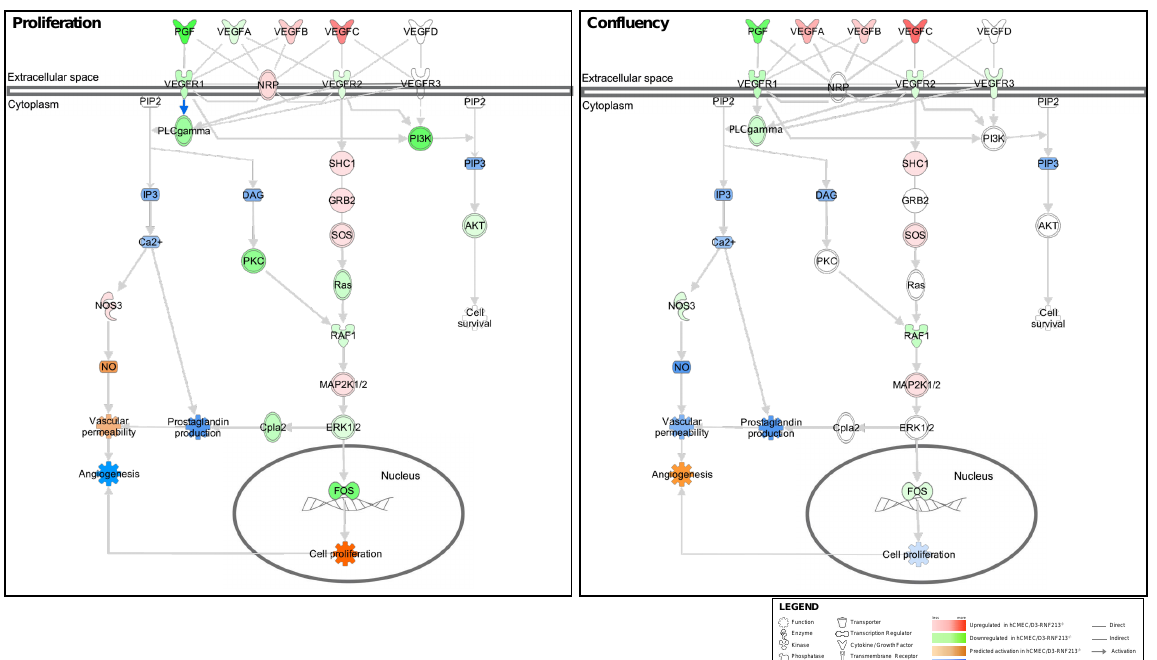
Figure 5. Enrichment of VEGF signaling pathway by the IPA software in proliferative and confluent hCMEC/D3 invalidated in RNF213. The signaling networks were generated with normalized genes expression values, which predict biological functions such as angiogenesis and cell